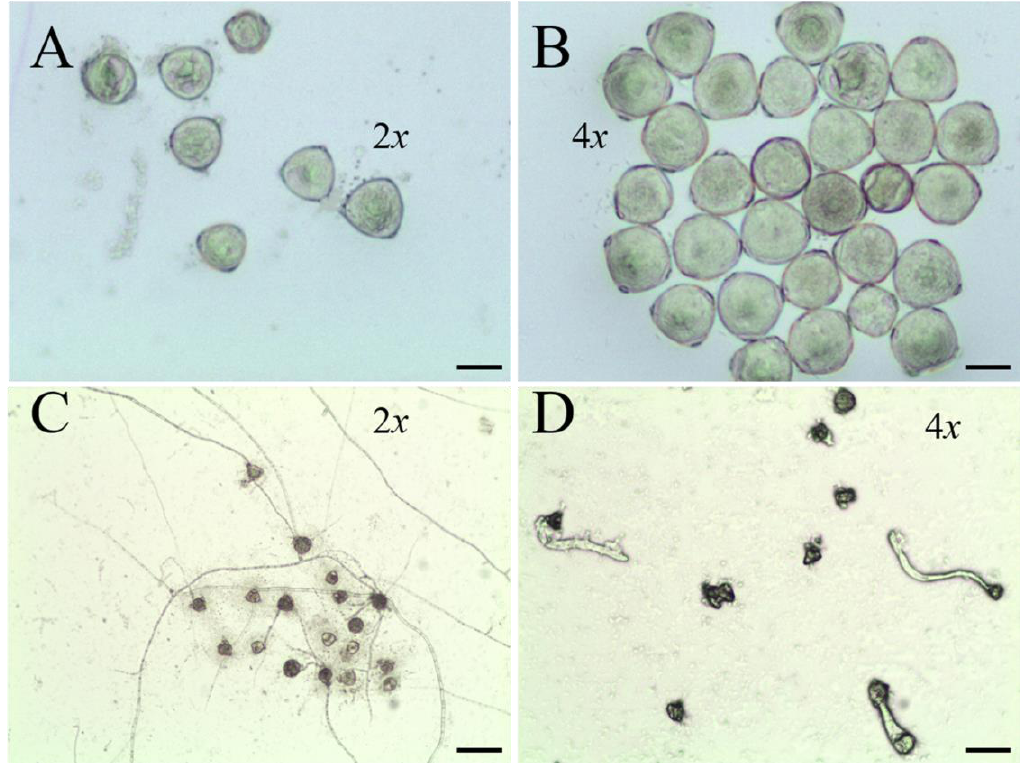
Figure 4. Pollen characteristics of ‘Xingtai 0604′ (2 x ) and ‘Zhuguang’ (4 x ). ( A ) The pollen sizes of ‘Xingtai 0604′ . ( B ) the pollen sizes of ‘Zhuguang’ . ( C ) the pollen activity of ‘Xingtai 0604′ . ( D ) the pollen activity of ‘Zhuguang’, ( A , B ), bars = 25 μm, ( C , D ), bars = 75 μ m.